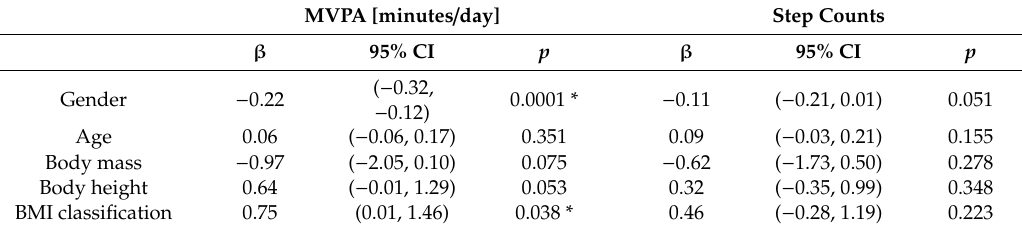
Table 4. Generalized linear models for MVPA and steps